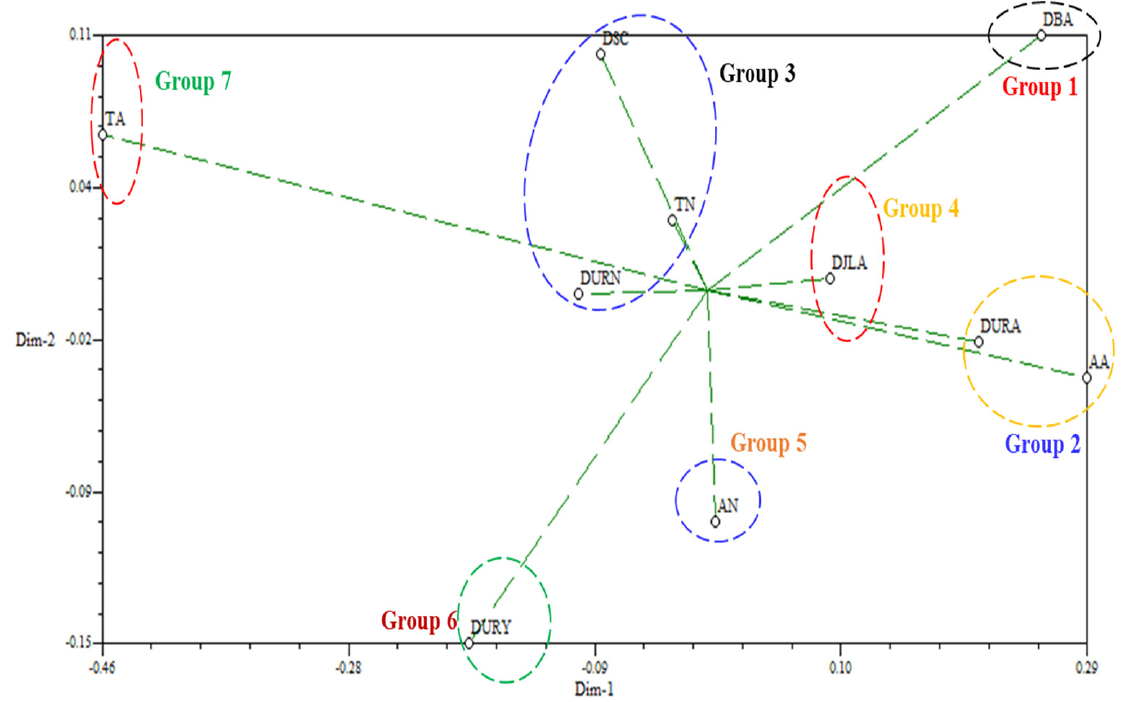
Figure 7. Two-dimensional plot of principal integral component analysis showing relationships among dura and pisifera parental origins: (A) AVROS, (DBA) Deli Banting × AVROS, (DURN) Deli Ulu Remis × Nigeria, (DJLA) Deli Johor Labis × AVROS, (DURA) Deli Ulu Remis × AVROS, (AA) Angola × AVROS, (TN) Tanzania × Nigeria, (DURY) Deli Ulu Remis × Yagambi, (AN) Angola × Nigeria, (TA) Tanzania × AVROS, and (DSC) Deli Serdang × Cameroon.